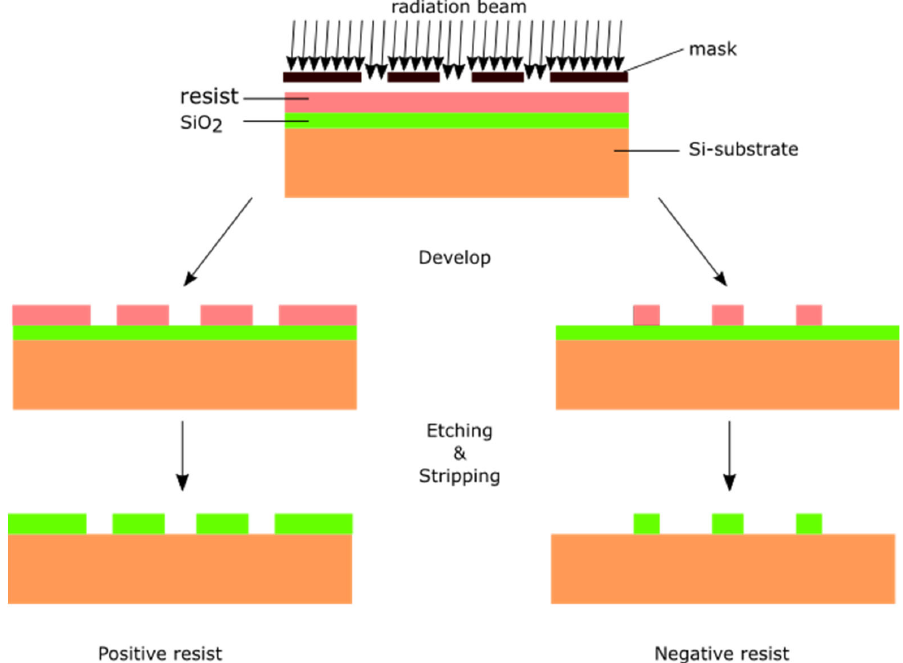
Figure 2. Principle of photolithography with positive and negative resists.